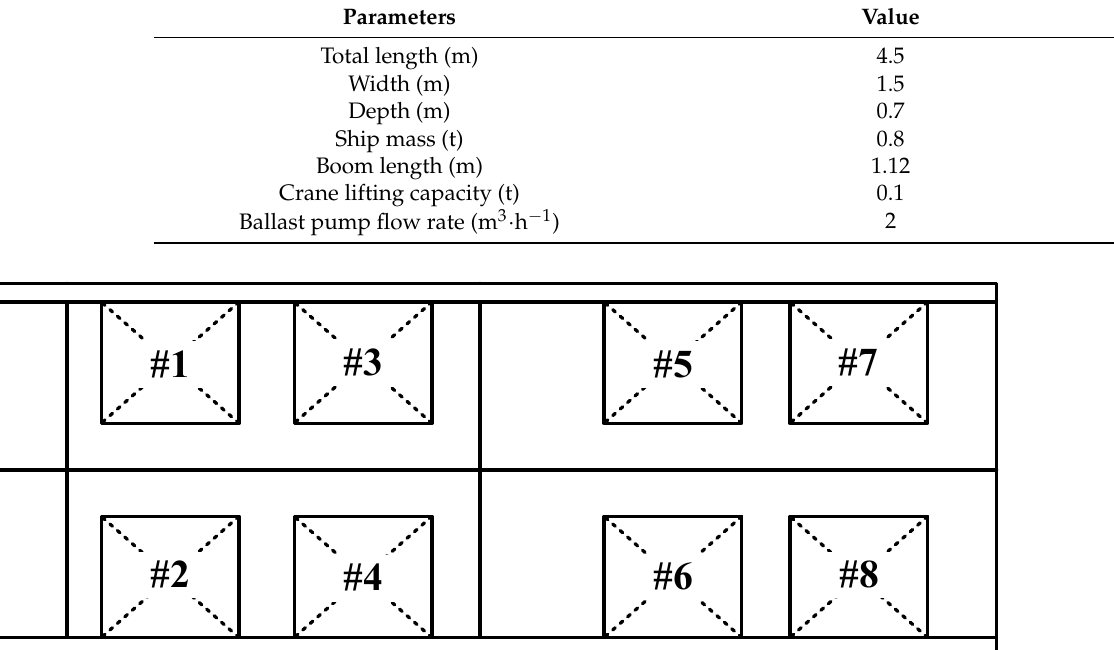
Figure 14. The ballast tank layout of the experimental RFC.